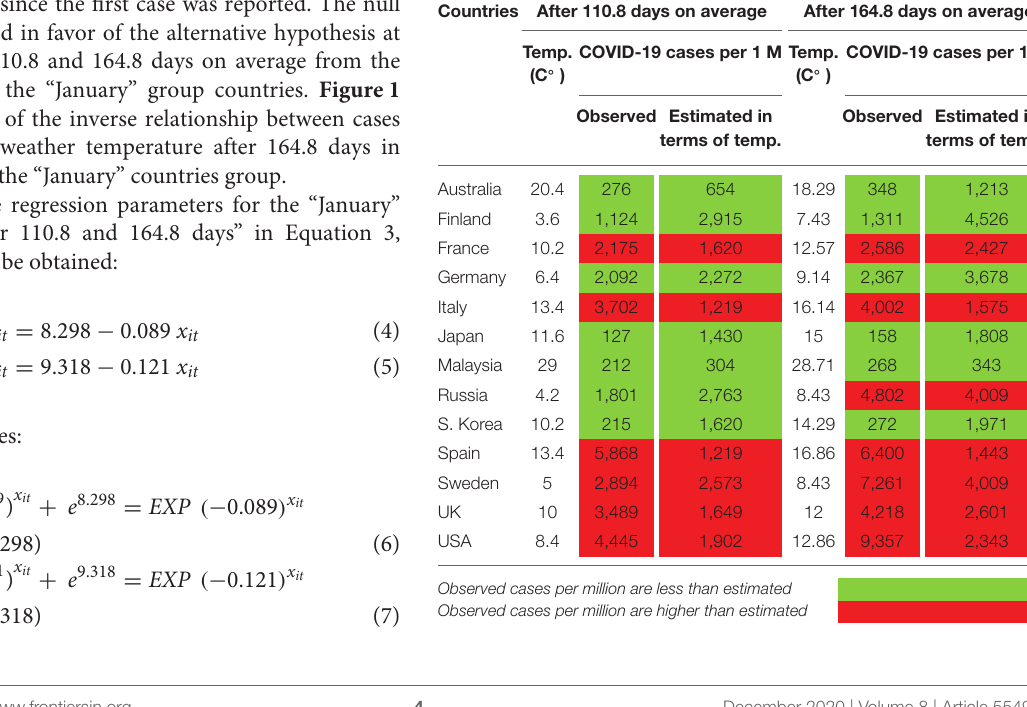
TABLE 2 | Observed and estimated COVID-19 cases per million, in terms of temperature in the “January-group” countries. Countries After 110.8 days on average After 164.8 days on